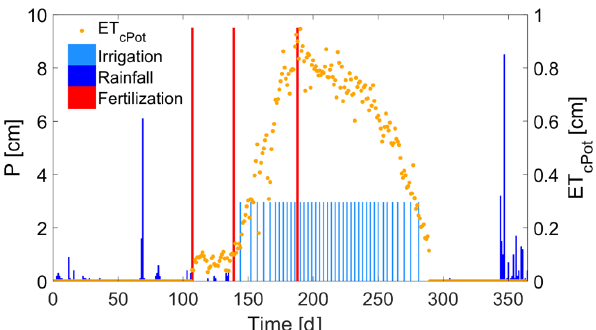
Figure 2. Illustration example of daily values of potential crop evap- otranspiration (orange points) used for the description of the upper boundary condition. The blue bars represent rainfall events and the light blue bars irrigation events. The red bar defines fertilization application for an amount equal to 65kgha − 1 (195kgha − 1 yr − 1 ). The crop is